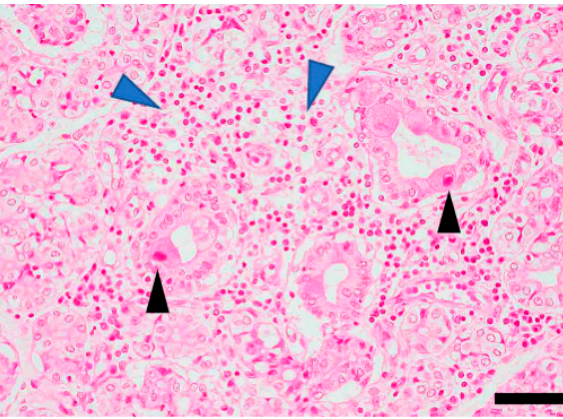
Figure 3. Histopathology of cytomegalovirus (CMV) infection in the salivary gland. HE-stained section of minor salivary glands prepared from lip biopsy. Blue arrowheads indicate inflammatory infiltrates. Black arrowheads indicate intranuclear inclusion bodies. Scale bar: 50 μ m. The image is unpublished.